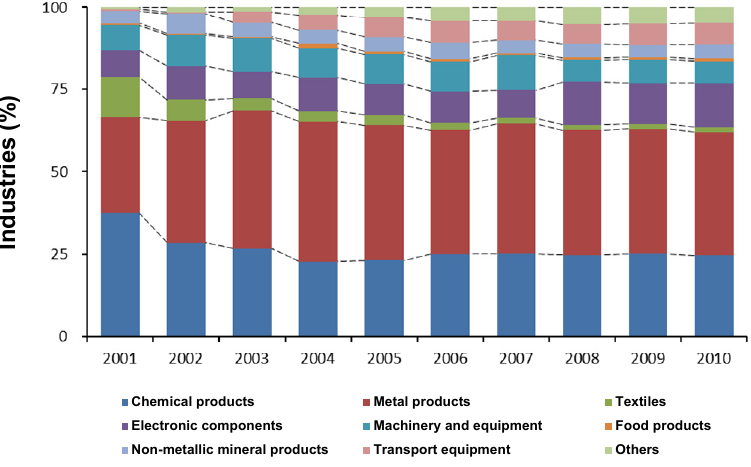
Figure 4. Changes of industrial types from 2001 to